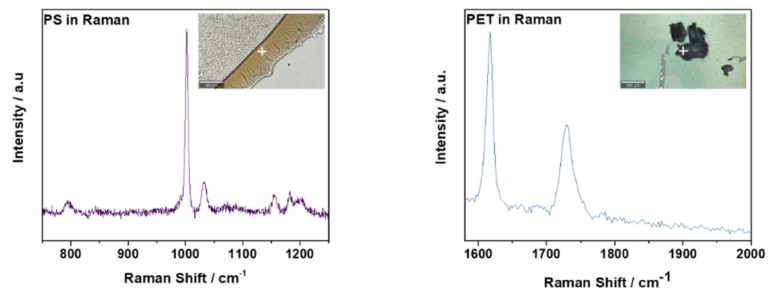
Figure A4. Representative Raman spectra measured for 161 nm PS sub-microparticles which were drop-cast in layers until a thick enough deposition was achieved to obtain a Raman signal (100 × mag- nification; scale bar 40 µ m) (left) and for stock milled PET microparticles (average size <170 µ m [22]; scale bar 200 µ m). Laser power, scan speeds, and number of averaged accumulations for the samples can be viewed in Table A1. Spectrum obtained are shown with the region of interest (ROI) the measurement was obtained from.